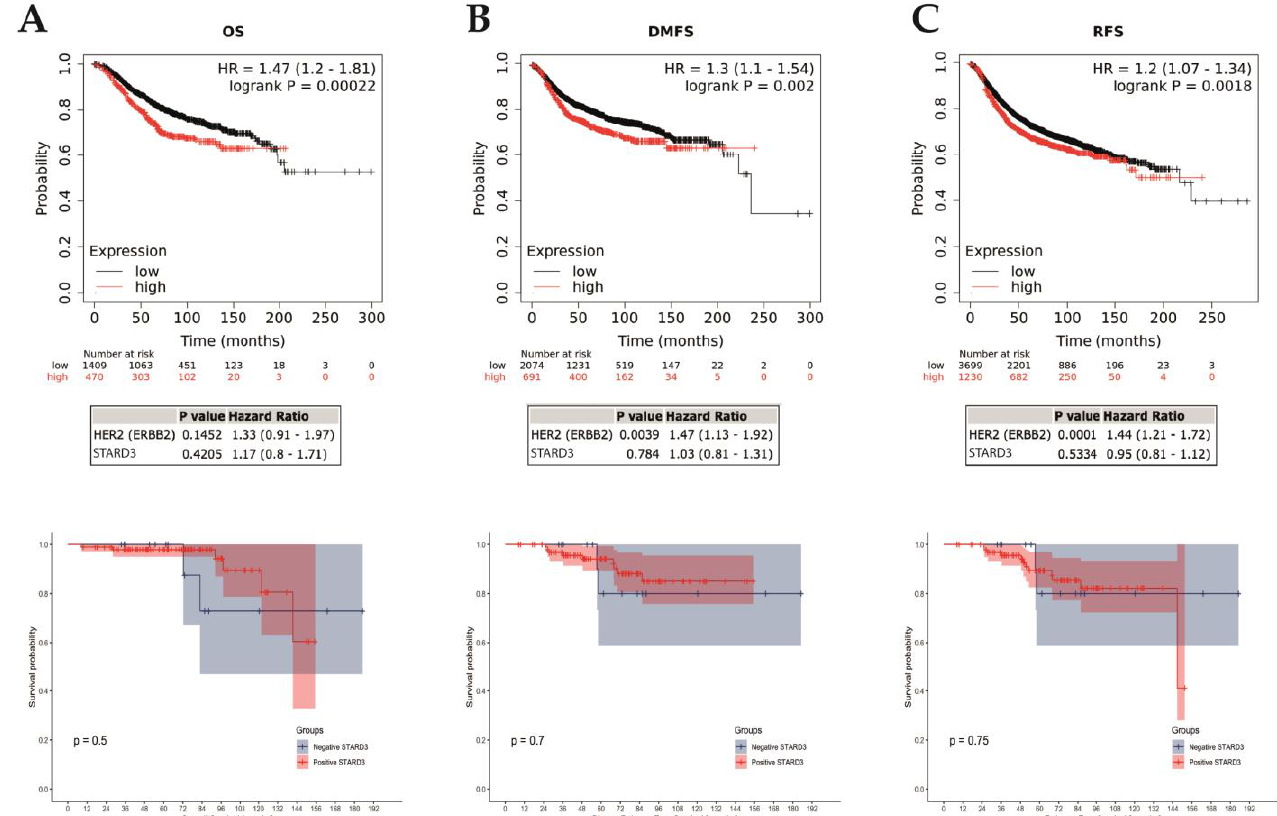
Figure 6. STARD3 prognosis. Association of STARD3 mRNA expression with survival ( A : overall [OS]; B : distant-metastasis free [DFMS]; C : relapse-free [RFS]) in a cohort of breast cancers from the Kaplan – Meier plotter (KM plotter database) in the upper row, with multivariate analysis on HER2 below. The last row shows survivals in the studied cohort. Of interest, there are cross-overs in the survival curves, which indicate a non-proportional hazard. Consequently, in this survival analysis, p -values (log-rank tests) must be interpreted with caution, given the greater risk of wrongly concluding a statistically significant difference.